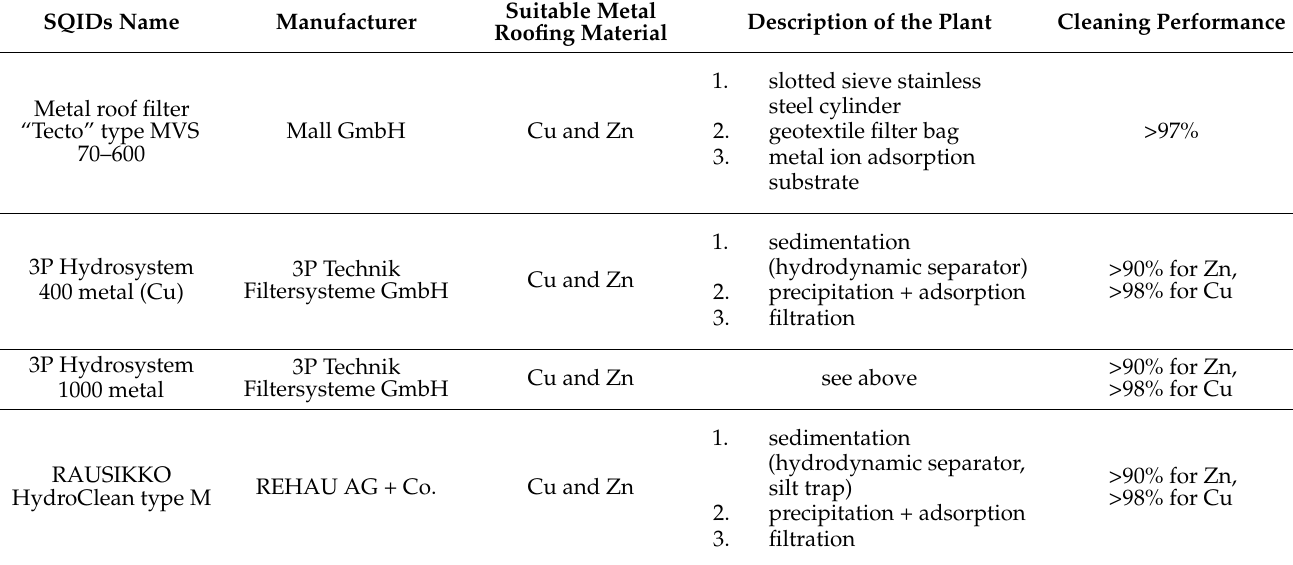
Table 4. Currently approved SQIDs for treating metal roof runoff (data according to